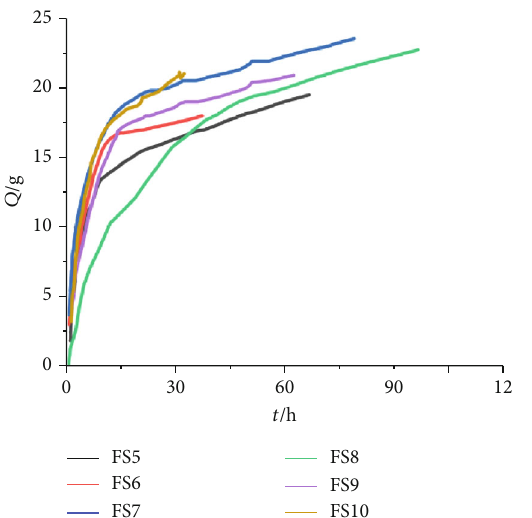
Figure 24: Uniaxial compression stress – strain curves of the siltstone samples at di ff erent water